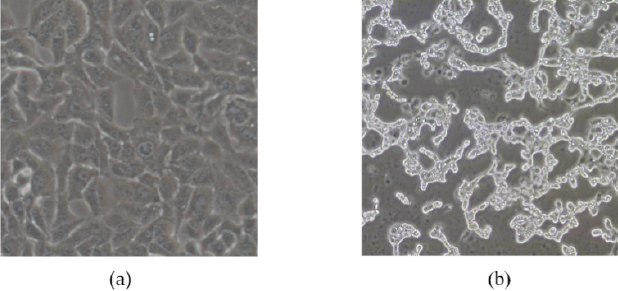
Figure 3. ( a ) The MOCK A549 cells; ( b ) A549 cells infected with pBRAdV14 – derived viruses. CPE was